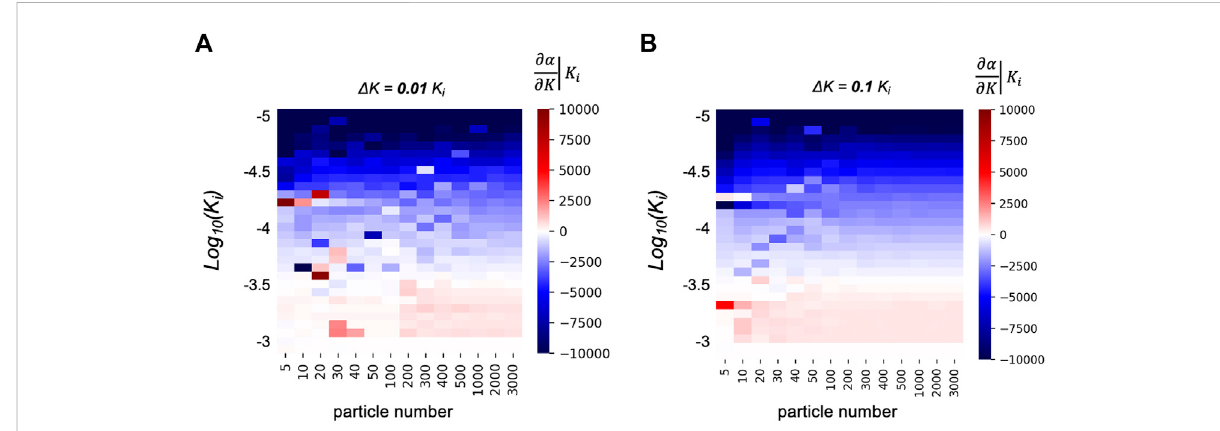
FIGURE 5 Exploration of derivatives quality behaviour regarding the number of particles with the hydraulic conductivity K i ranging from 10 – 5 to 10 – 3 m s − 1 and the increment Δ K set to (A) 0.01 × K i and (B) 0.1 × K i